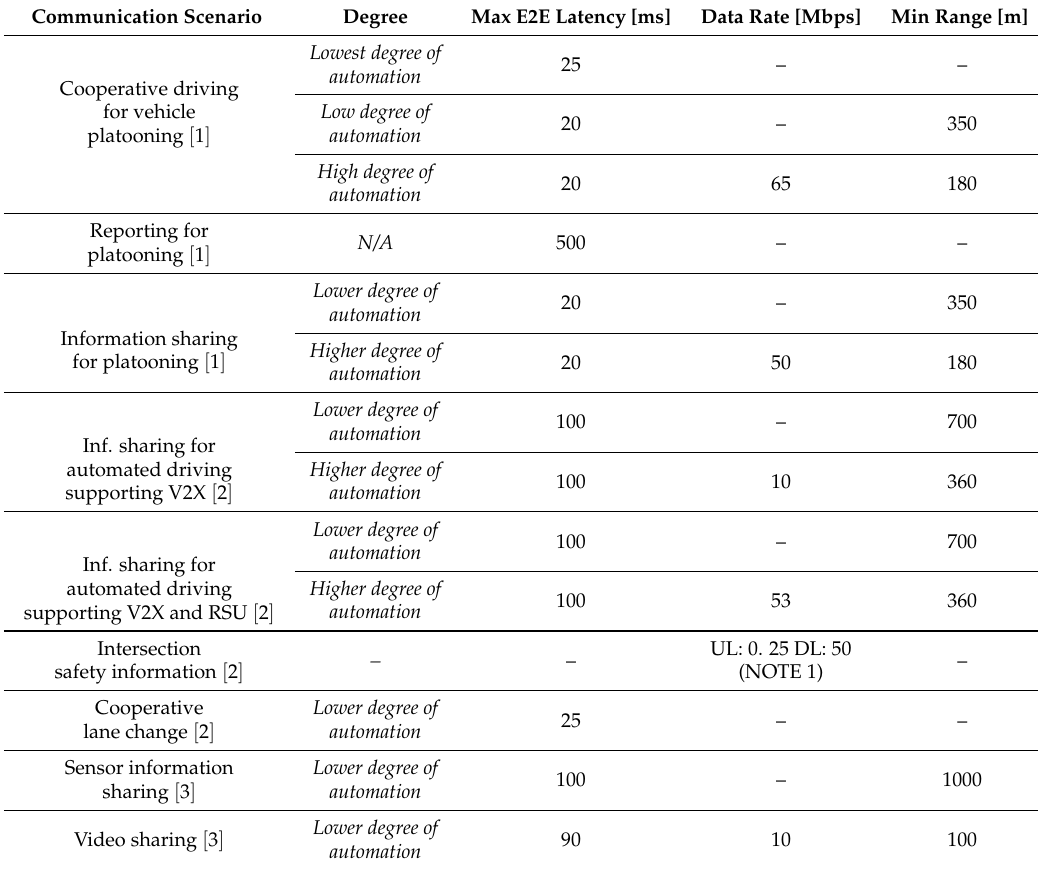
Table 5. Achievable V2X scenarios with current solutions—based on 3GPP TS 22.186